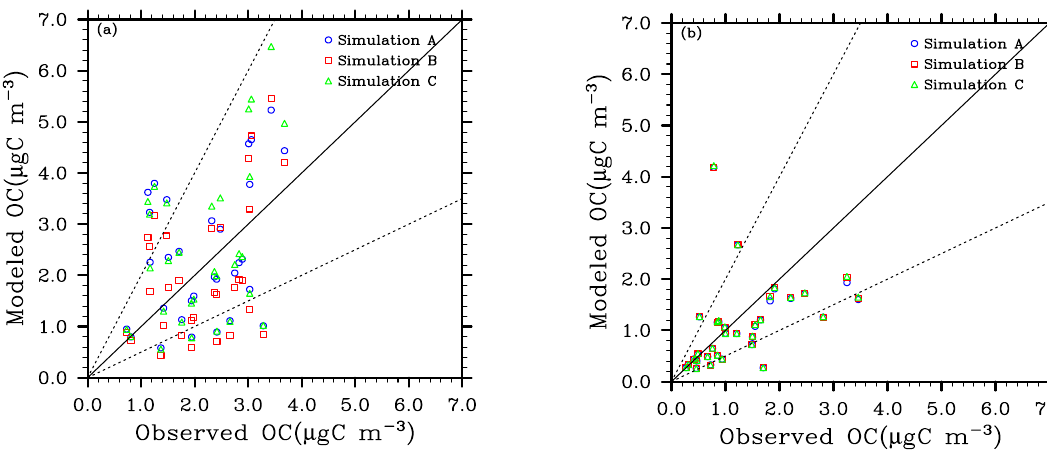
Fig. 5. Simulated versus observed seasonal mean OC concentrations for the IMPROVE network. (a) summer (JJA) and (b) winter (DJF). The solid lines represent ideal agreement (1:1 ratio), and the dashed lines are the 2:1 and 1:2 ratios. The IMPROVE network data are from 1996 to 1999. The meteorology data used to run the model were for